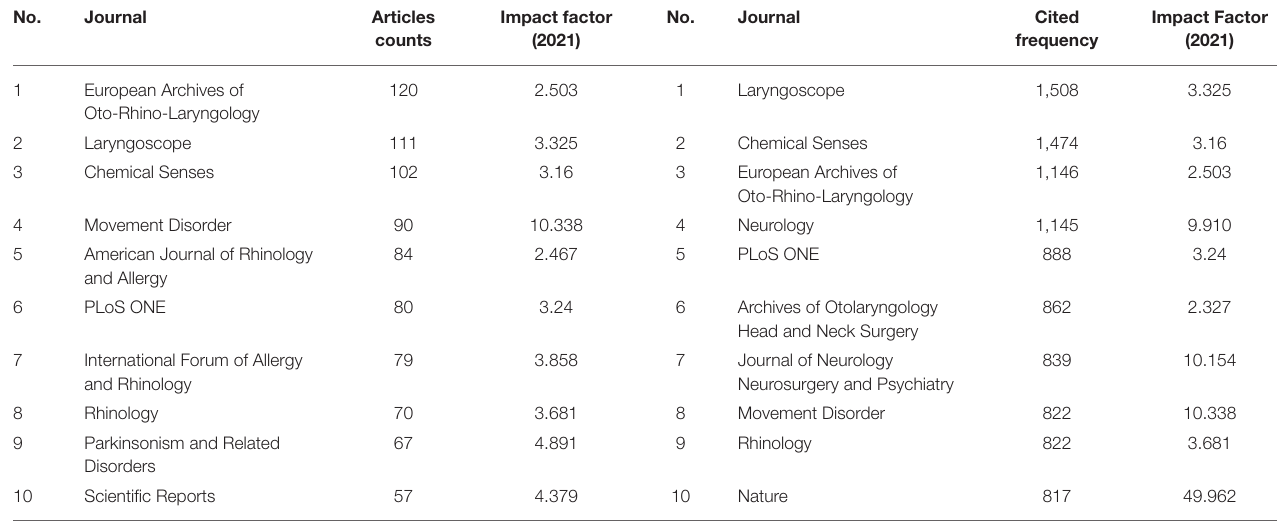
TABLE 4 | Top 10 most popular journals and co-citations of journals in the field of olfactory dysfunction from 2002 to 2021.